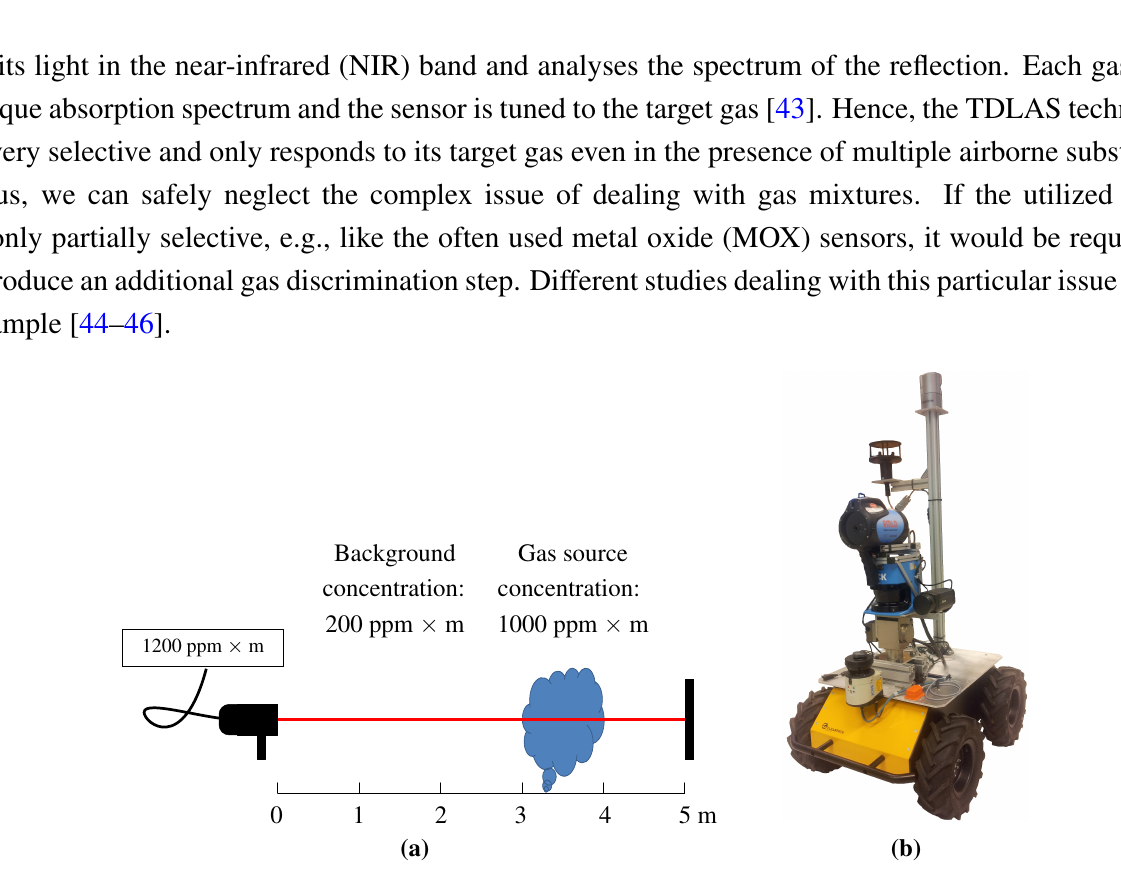
Figure 1. ( a ) the Remote Methane Leak Detector is a TDLAS sensor which can report the integral concentration of methane along its laser beam (parts per million × meter); ( b ) Gasbot , a robotic platform for gas